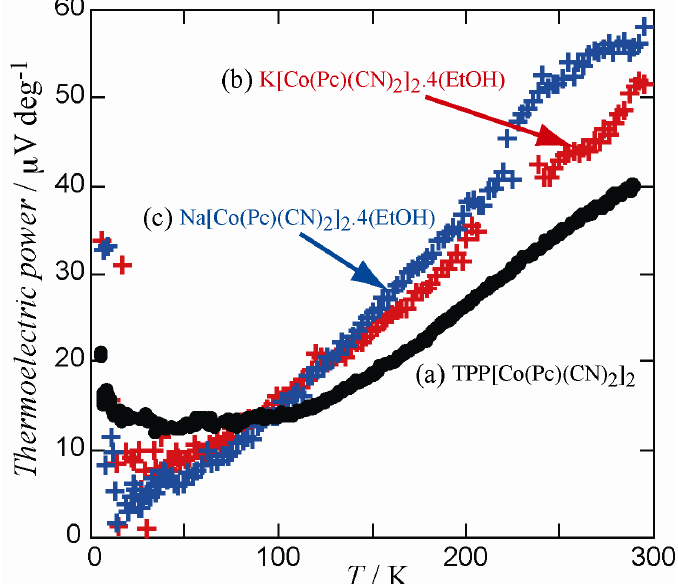
Figure 6. Temperature dependence of the thermoelectric power along the c axis